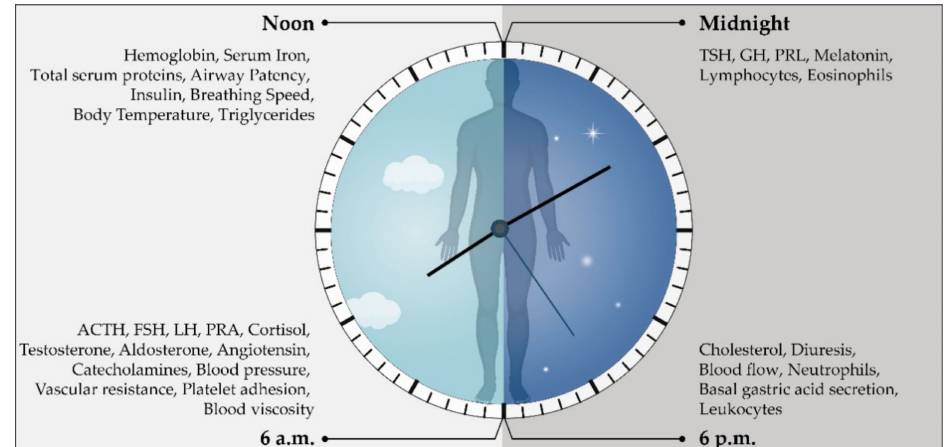
Figure 4. A human circadian clock—an overview of the most pronounced activities of individual processes and secretions of substances in the human body (ACTH—an adrenocorticotropic hormone, FSH—a follicle-stimulating hormone, LH—a luteinizing hormone, PRA—plasma renin activity, TSH—a thyroid-stimulating hormone, GH—growth hormone, PRL— prolactin). The image was created with the Adobe Illustrator CC (Version 23.0.1.; Adobe Inc., 2019)